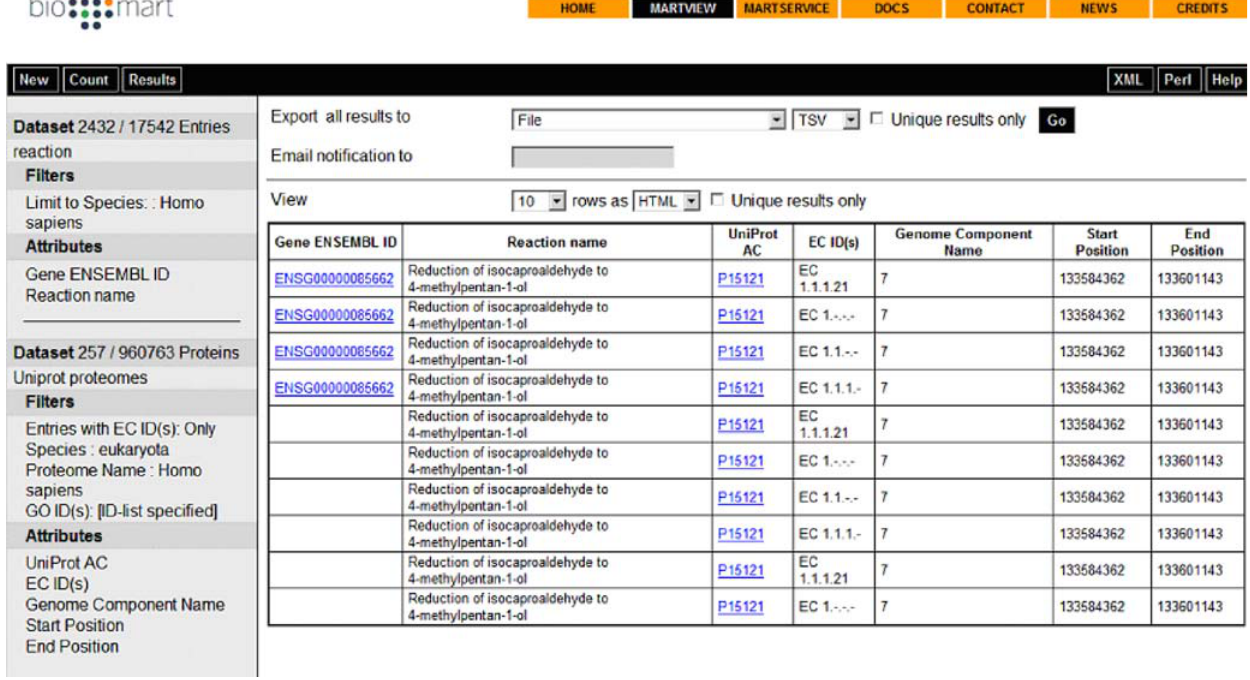
Figure 2. BioMart can join different datasets, in this case Reactome and UniProt to identify enzymes involved in carbohydrate metabolism.